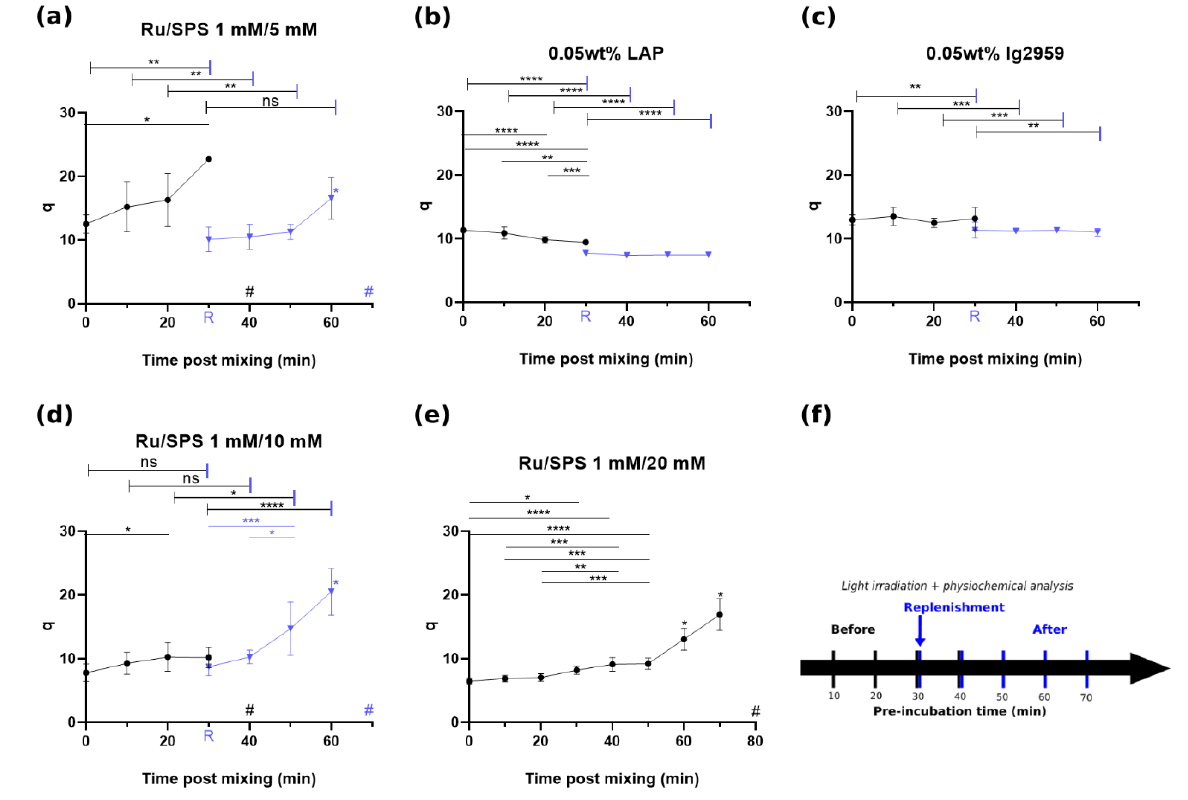
Figure 2. Mass swelling ratio of GelAGE versus pre-incubation time prior to crosslinking with flow chart, circle ( • ) represents crosslinking with designated time of pre-incubation and triangle ( ▼ ) represents the samples with further pre-incubation after replenishment of photoinitiator at t = 30 min: ( a ) q: 1 mM/5 mM Ru/SPS, ( b ) q: LAP, ( c ) q: Ig2959, ( d ) q: 1 mM/10 mM Ru/SPS and ( e ) q: 1 mM/20 mM Ru/SPS and ( f ) flow chart of experiment. Values in the figures represent mean and standard deviation of N = 9 replicates. Capped lines are for comparison with different groups (before and after replenishment) while straight lines are for comparison within the same group. Asterisks (*) represents values statistically significant at the p < 0.05 level, ** for p < 0.01, *** for p < 0.001 and **** for p < 0.0001. Pound(#) sign represents no-gel formation. ns represents values statistically non-signigicant.